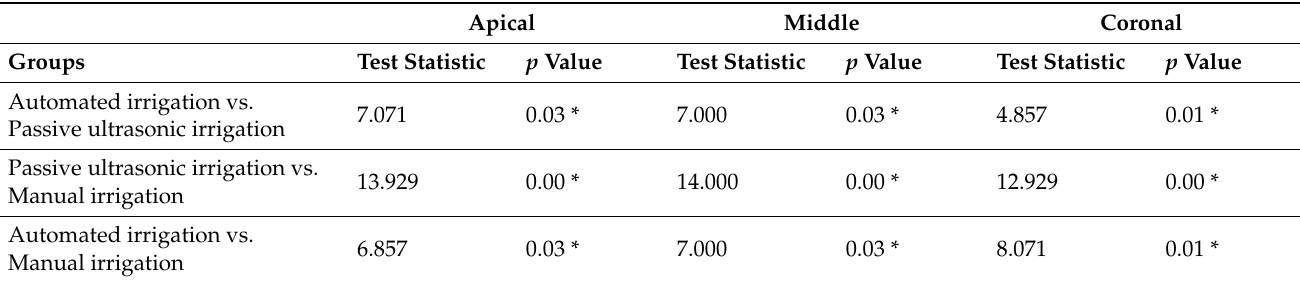
Table 3. Pairwise comparison of mean smear